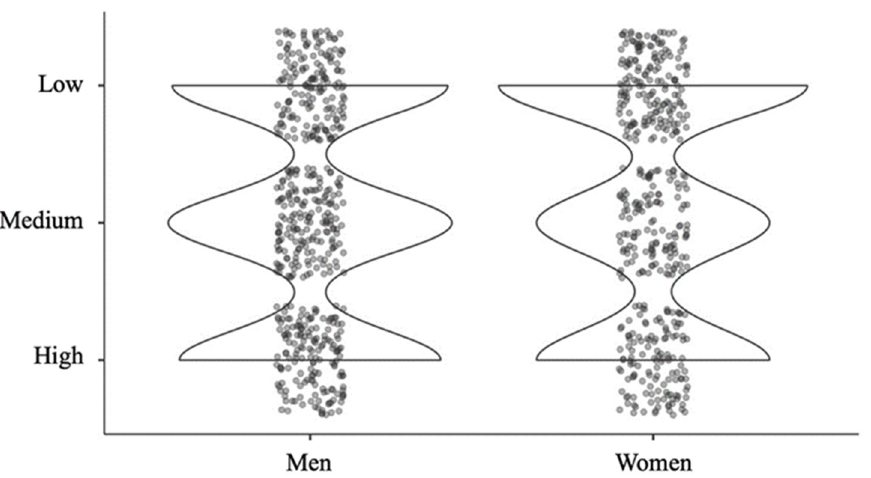
175) (Figure 2). (Figure 2).